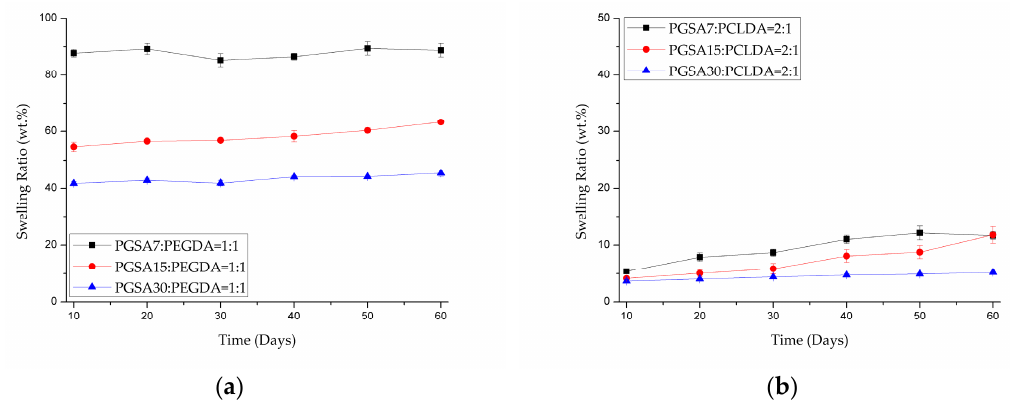
Figure 5. Swelling ratio of ( a ) PGSA- co -PEGDA and ( b ) PGSA- co -PCLDA over 60 days of degradation in 20 U/mL lipase solution at 37 °C. ( n ≥ 3).